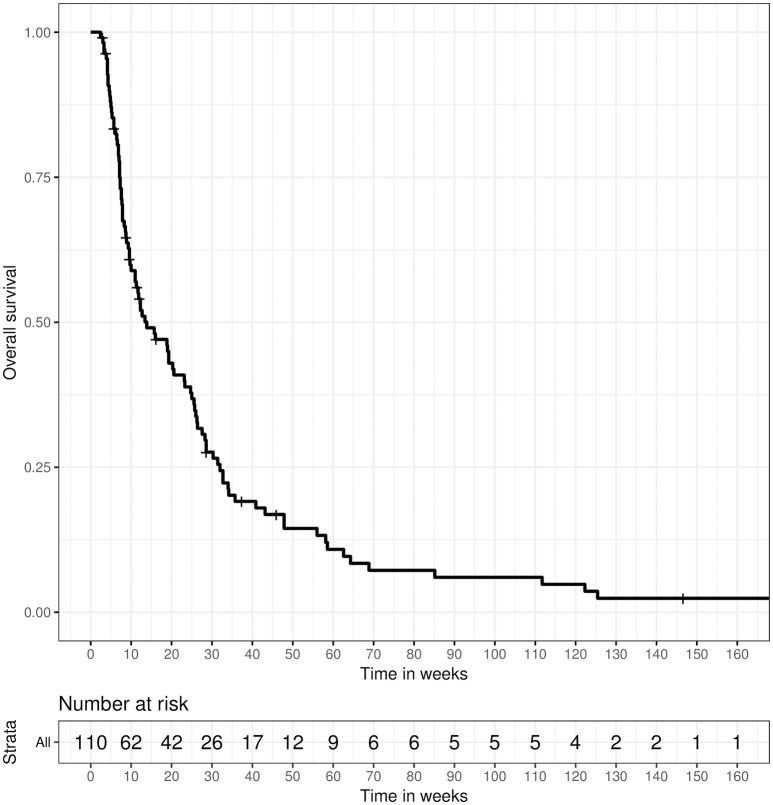
Overall survival for 110 patients receiving radiotherapy for the treatment of LC, calculated from the date of LC diagnosis until death or last follow-up.